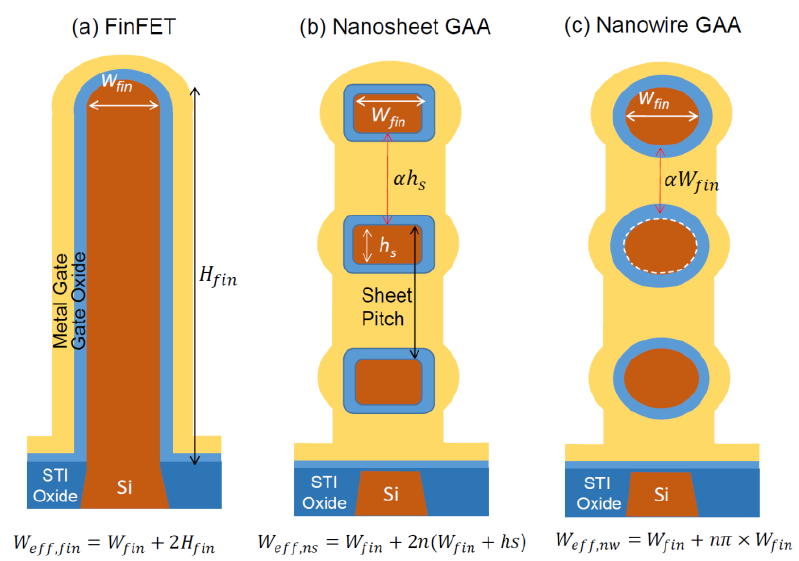
Figure 1. Comparison of ( a ) FinFET, ( b ) vertically stacked nanosheet GAA FET, and ( c ) vertically stacked nanowire GAA FET with the same footprint width of W fin and fin height of H fin . The formulae in the bottom show the overall effective gate width of the transistors. The numbers of nanosheets and nanowires depend on the sheet/wire sizes and the intersheet or interwire spacing.